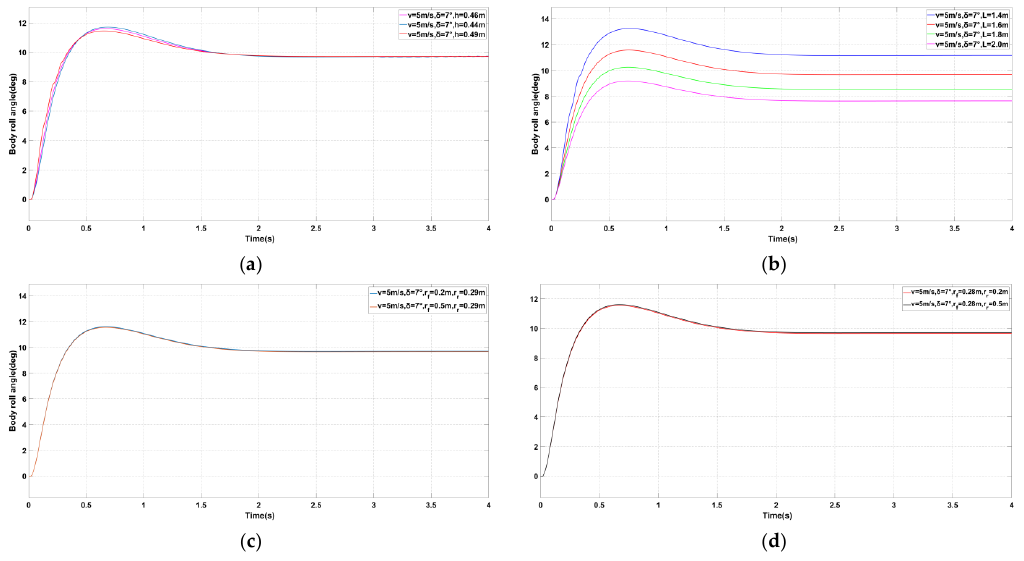
Figure 11. Effect of model parameter changes on control effects: ( a ) Effect of a change in center-of-a mass height; ( b ) Effect of a wheelbase change; ( c ) Effect of change in the front wheel radius; ( d ) Effect of a change in the rear wheel radius.